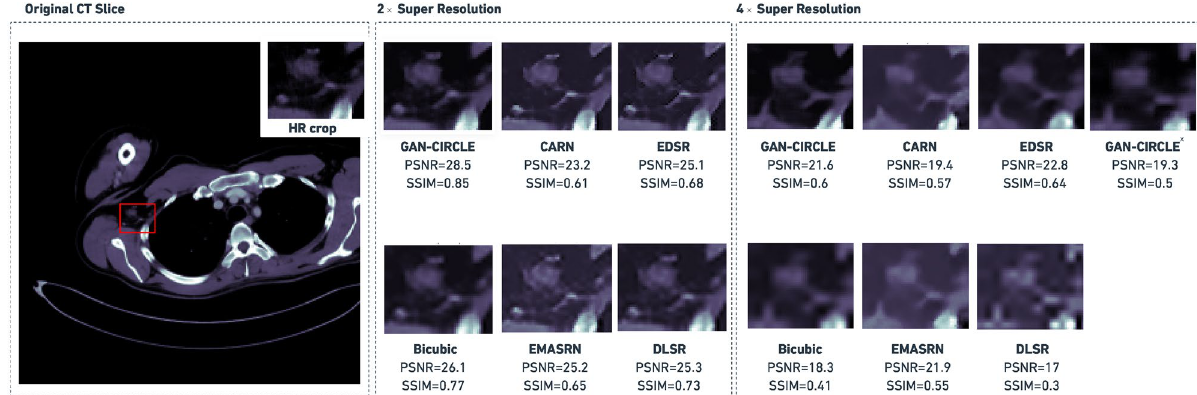
Figure 3. Perceptual quality comparison, on the DeepLesion test images 2 × and 4 × super-resolved held out for performance evaluation, obtained by the investigated SR methods. The PSNR and SSIM values are shown at the bottom of each super-resolved image. In the case of 4 × SR, GAN-CIRCLE x denotes the sequential application of two GAN-CIRCLE instances at 2 ×